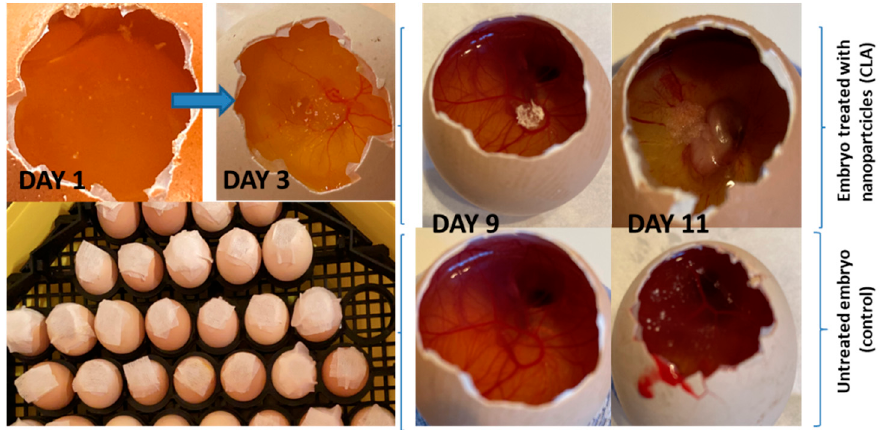
Figure 6. CAM Angiogenesis Model: macroscopic images (after 1, 3, 9, and 11 days of incubation in the presence (CLA) and in the absence of nanoparticles (CL—control)).